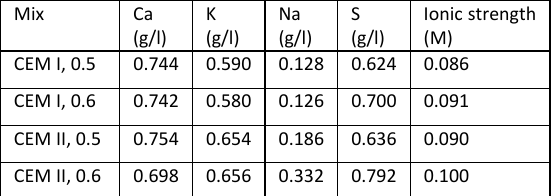
Table 1. Composition of pore solution extracted from fully carbonated (4% CO 2 ) and water saturated samples obtained from ICP